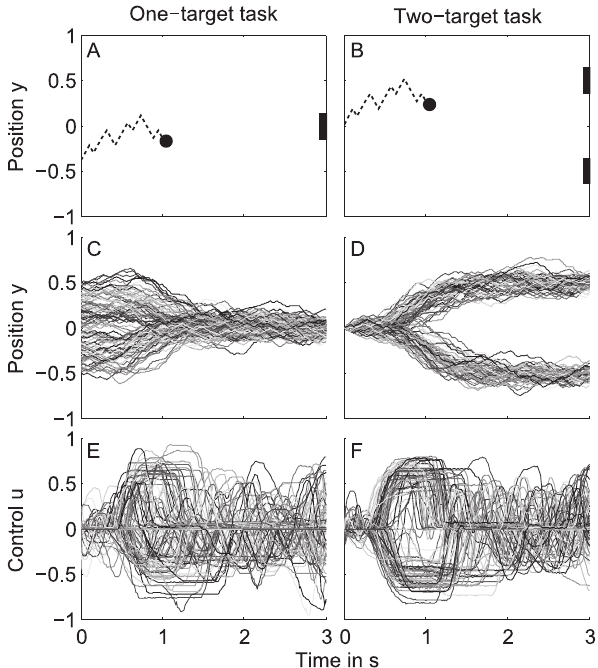
Figure 1. Schematic of the tasks. (a) In the one-target task (left panel), subjects had to control a joystick to move a ball on a screen to hit a target (rectangle) at time t ~ 3 s. The ball (circle) started at a random vertical position between { 0 : 5 and 0.5 at the left of the screen and moved at a constant horizontal velocity to the right. Subjects could move the ball up- or downwards. Gaussian white noise was superimposed on the vertical ball position to introduce uncertainty about future ball positions. The dashed line illustrates the trajectory of the ball. (b) In the two-target task (right panel), two targets were present at vertical positions { 0 : 5 and 0.5. The ball started at vertical position y ~ 0 at the left of the screen. Subjects were asked to steer to one of the targets and they were free to choose which one. All other experimental conditions were exactly the same as for the one-target task. (c) Ball position time traces (100 trials) of subject S6 performing the one-target task with noise amplitude n ~ 0 : 009 . (d) Same for the two- target task. (e) Control signal time traces corresponding to the ball position time traces in panel c (100 trials) of subject S6 performing the one-target task with noise amplitude n ~ 0 : 009 . (f) Same for the two- target task.